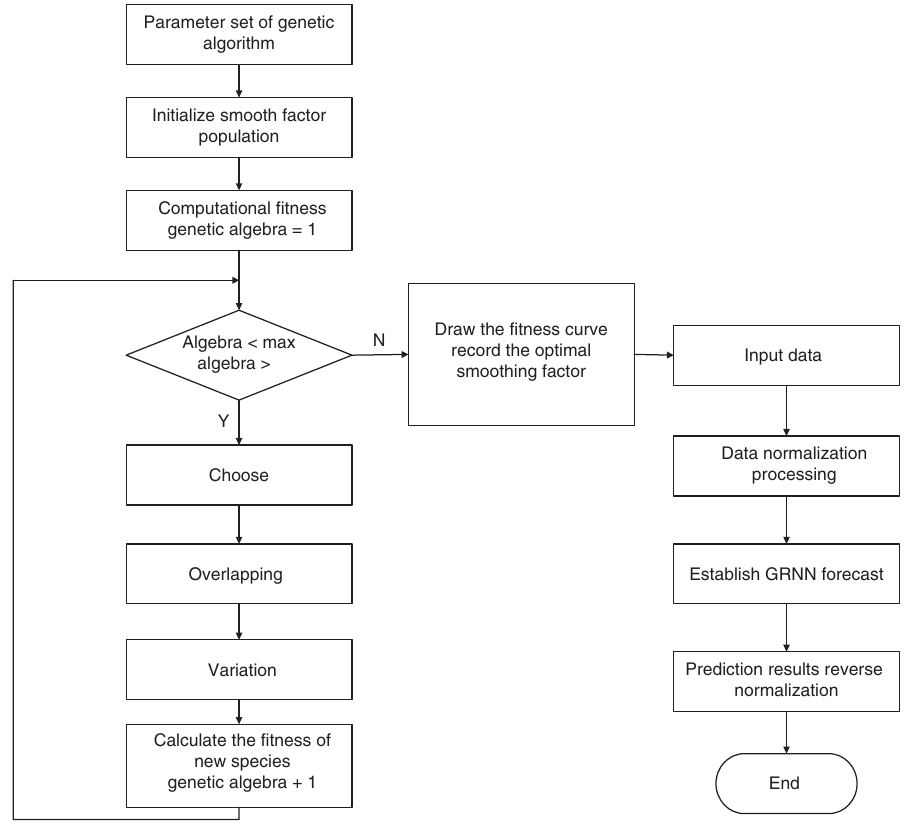
Figure 1: Genetic Improvement GRNN Method Forecast